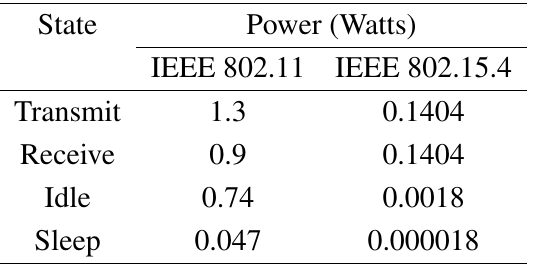
Table 1. Power value in each radio